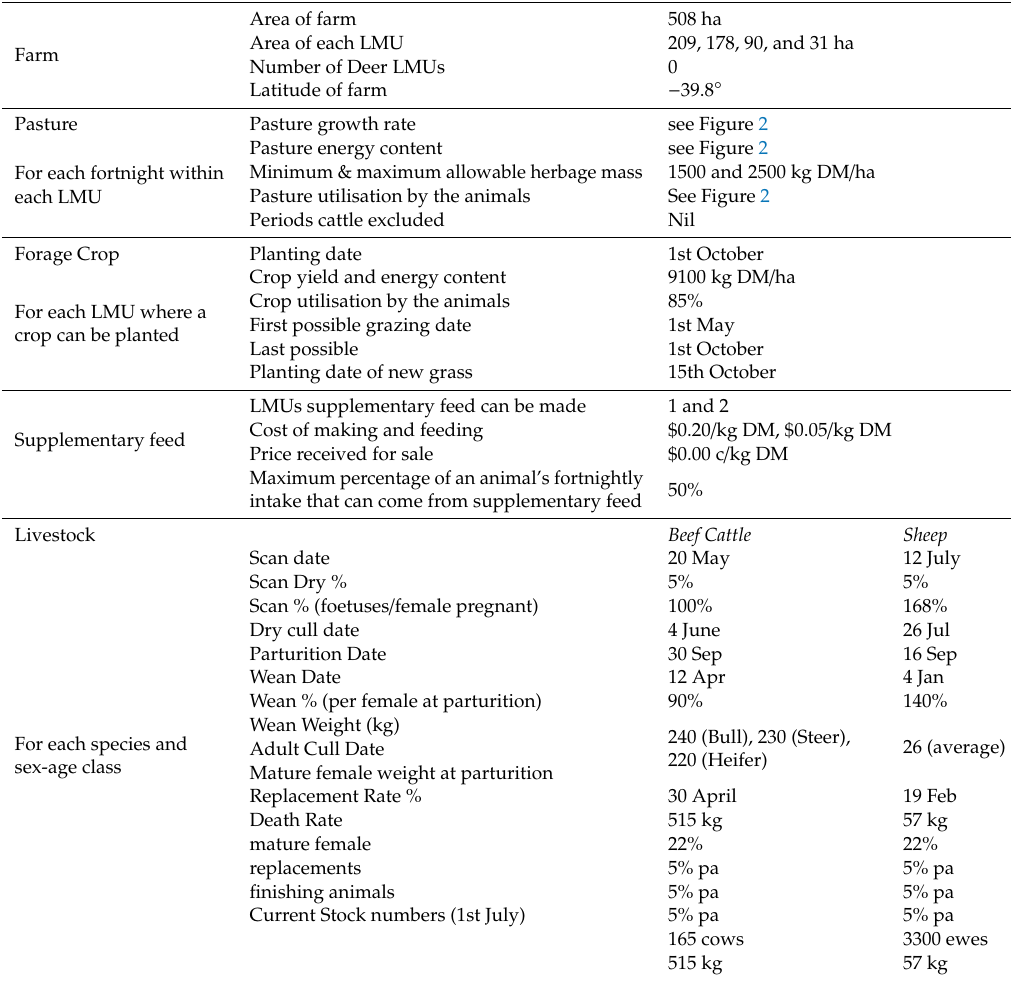
Table A1. Inputs data for the farm-level case (Base farm) required for AgInform ®